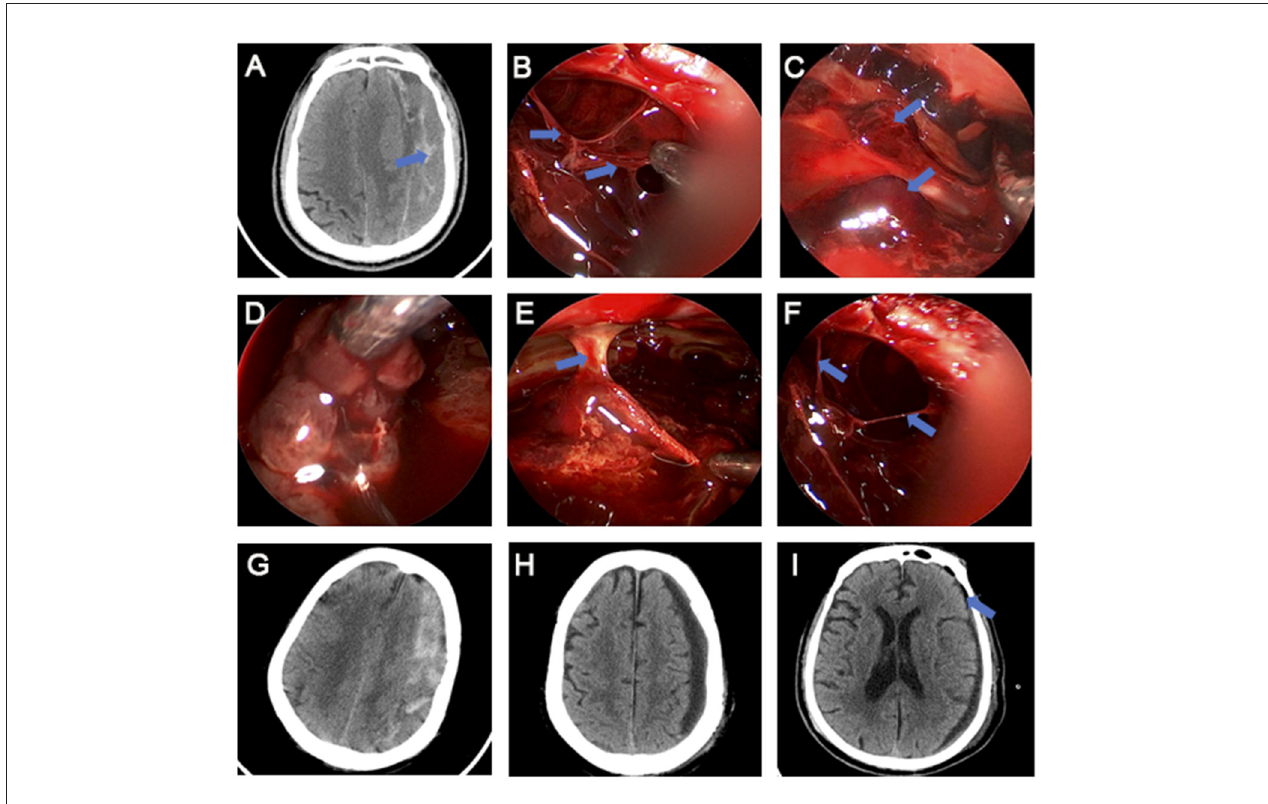
FIGURE 3 | Preoperative and postoperative CT images and intraoperative images of rigid neuroendoscopy of CSDH. (A,B) Multiple-septum (blue arrow) of the hematoma. (C) Blood clots (blue arrow) that adhere closely to the capsule. (D) Suction of the incomplete liquefied hematoma. (E) A columnar trabecular structure (blue arrow) formed by the adhesion of the parietal and visceral envelope. (F) Bridging veins (blue arrow) in the hematoma cavity. (G,H) Comparison of preoperative (G) and postoperative (H) CT in a patient with the mixed density CSDH treated with rigid neuroendoscopy. (I) Little postoperative pneumocephalus (blue arrow) after rigid neuroendoscopy treatment.